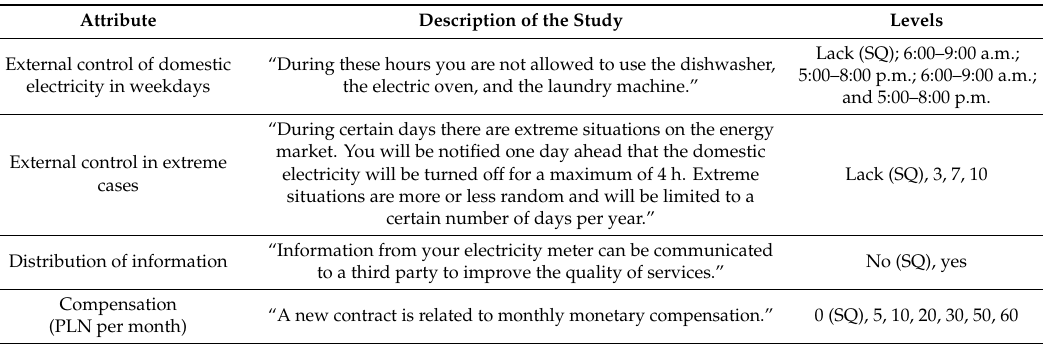
Table 1. Attributes and their levels. Reprint with permission Goł˛ebiowska, B., Bartczak, A., & Budzi´nski, W.; Copyright 2020, University of Warsaw Faculty of Economic Sciences. https: // www.wne.uw.edu.pl / files / 6115 / 6501 / 8862 / WNE_WP295.pdf. Description of the Study